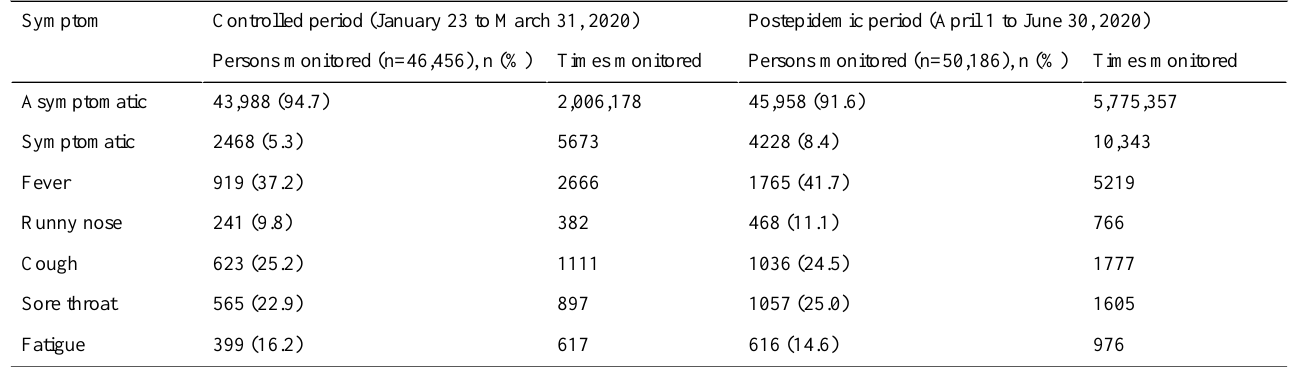
Table 3. Results of the COVID-19–related symptom monitoring